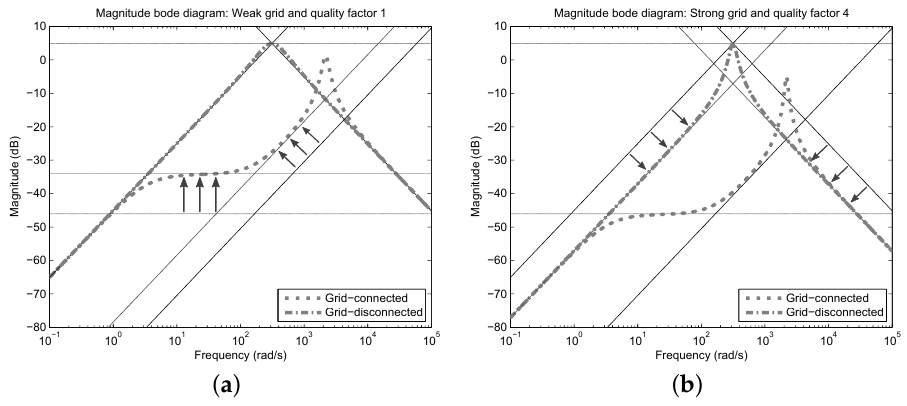
Figure 11. Bode diagram of the impedance at the PCC (magnitude plot). ( a ) Weak grid effect. ( b ) q factor effect (increase value).